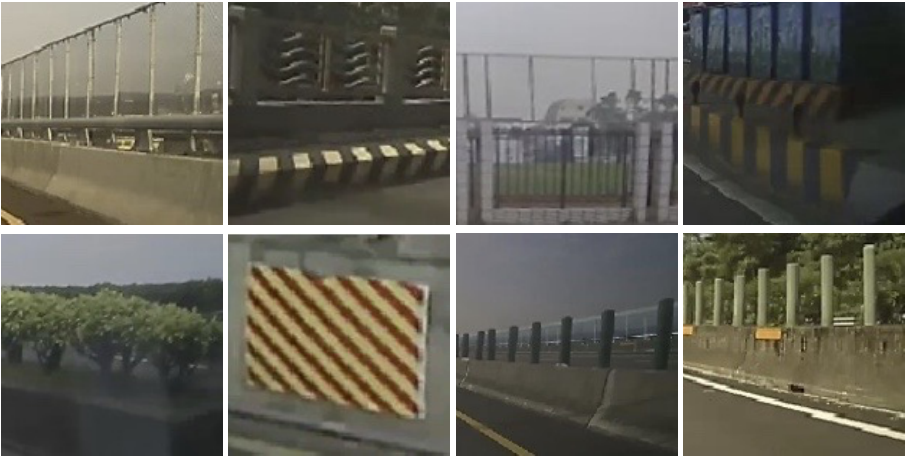
Figure 10. Some common repetitive patterns in the street